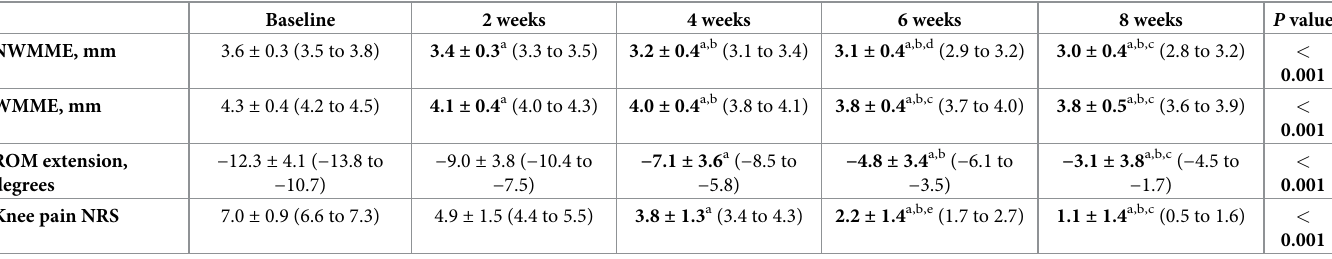
Table 2. Statistical analyses of temporal changes of the parameters.